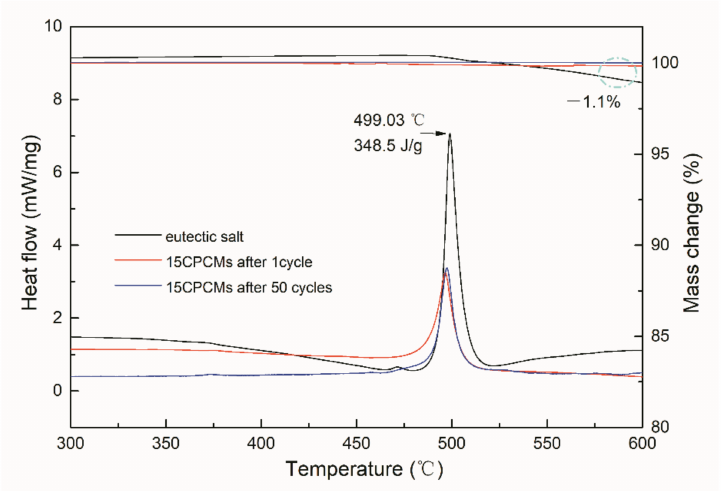
Figure 6. TG-DSC curves for eutectic salt and 15CPCMs after 1 cycle and 50 cycles.